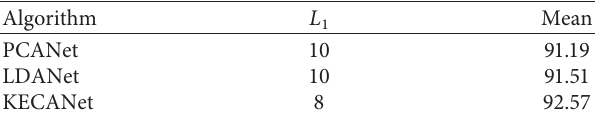
1 using CMU Multi-PIE dataset. Table 2: The recognition rate of CK+